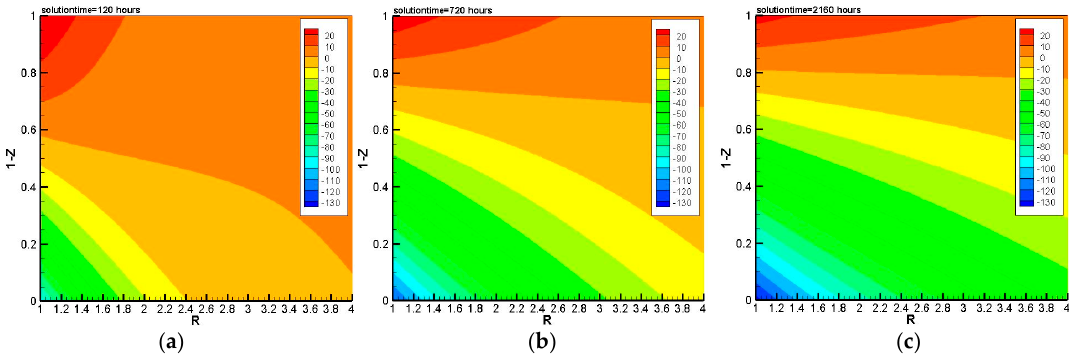
Figure 6. Contours for temperature change in the surrounding rock at different circulation times for T in* = 36.5 °C, B 0 = 27 °C and Q d = Q a = 25 kg/s; ( a ) t = 5 days, ( b ) t = 1 month; and ( c ) t = 3 months.